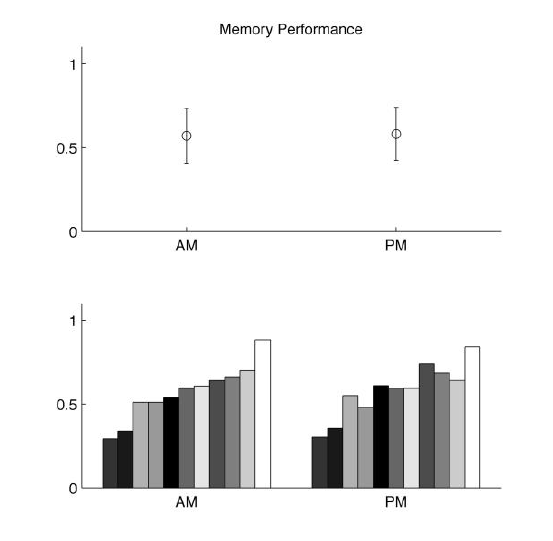
Figure 3. Whether the subjects were performing anti- saccade (AM) or pro-saccade (PM), there was no significant difference in the working memory performance. Subject-wide data is shown at the bottom. The performance of 0.5 indicates that the subject was able to recall 4 out of 8 digits correctly. The same gray scale as in Figure 2 codes individual subject.